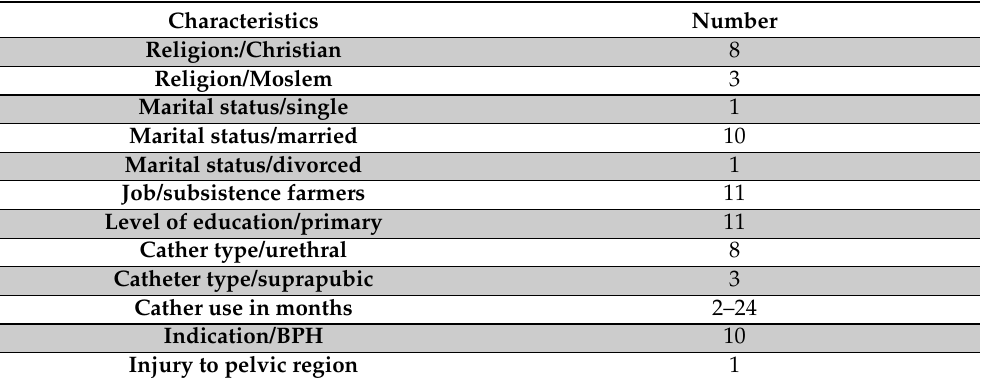
Table 1. Participants’ socio-demographic